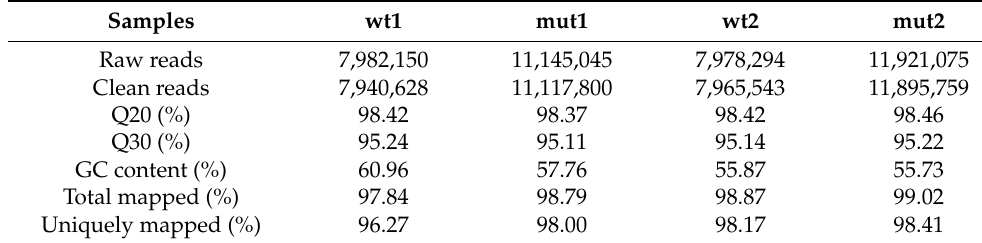
Table 1. Summary of RNA-seq data.